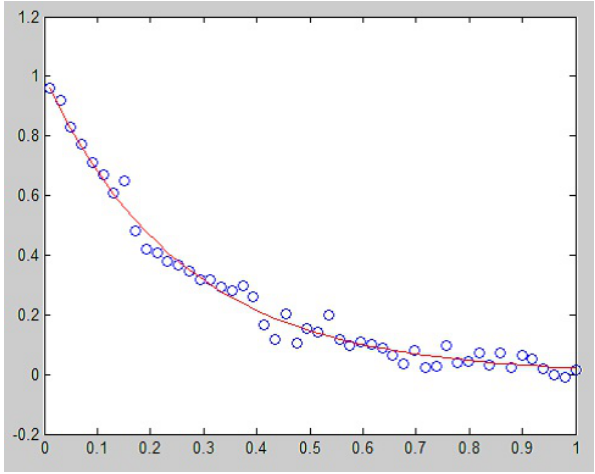
Fig. 2 Least squares fitting